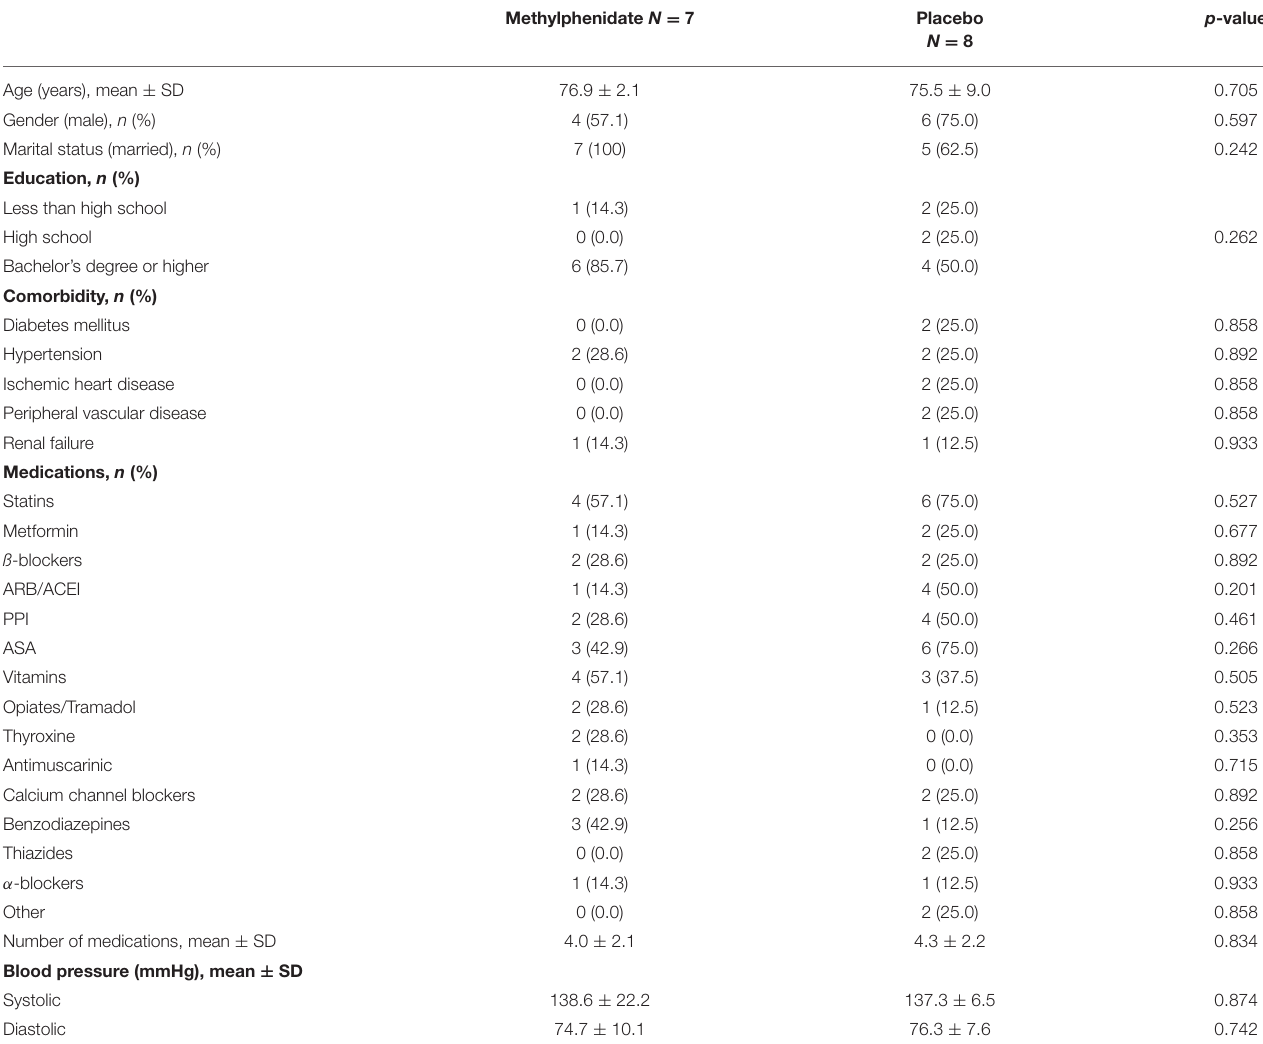
TABLE 1 | Baseline demographic and clinical characteristics of the study